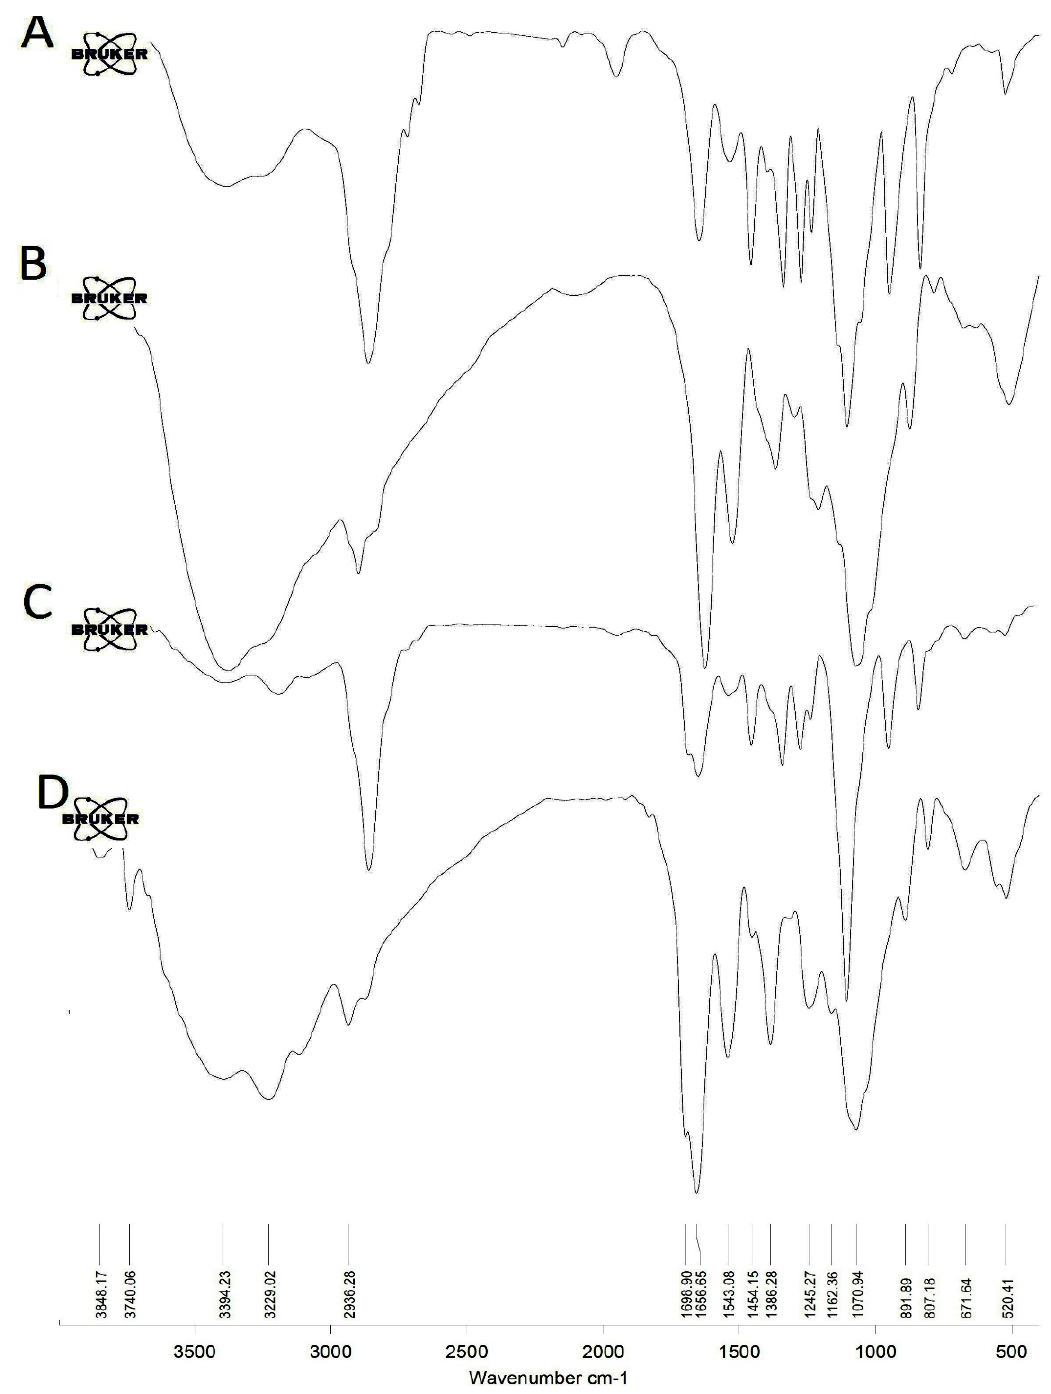
Figure 1. FTIR spectra for the synthesized iodine nanoparticles. ( A ) Amino-PEG iodine nanoparticles, ( B ) chitosan iodine nanoparticles, ( C ) oxaliplatin-loaded Amino-PEG/iodine nanoparticles, and ( D ) oxaliplatin-loaded chitosan/iodine nanoparticles.